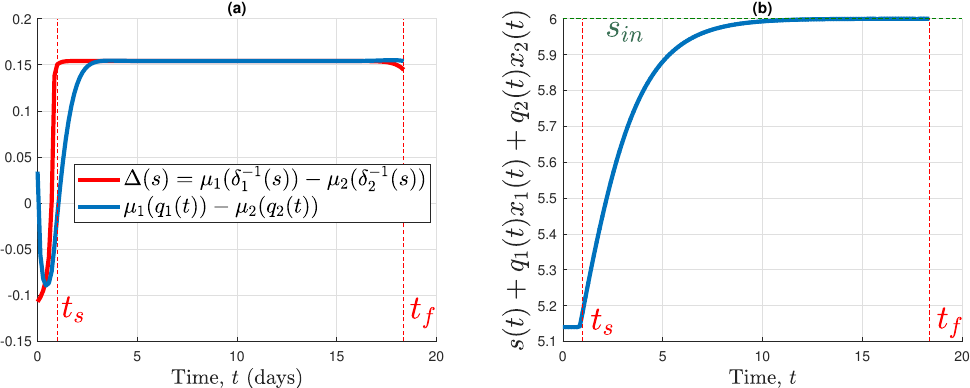
Figure 9. ( a ) Evolution of ∆ ( s ( t )) and µ 1 ( q 1 ( t )) − µ 2 ( q 2 ( t )) along the optimal trajectories. The opti- mal control aims to maximize the function ∆ . We also check in ( b ), using the optimal model trajectories